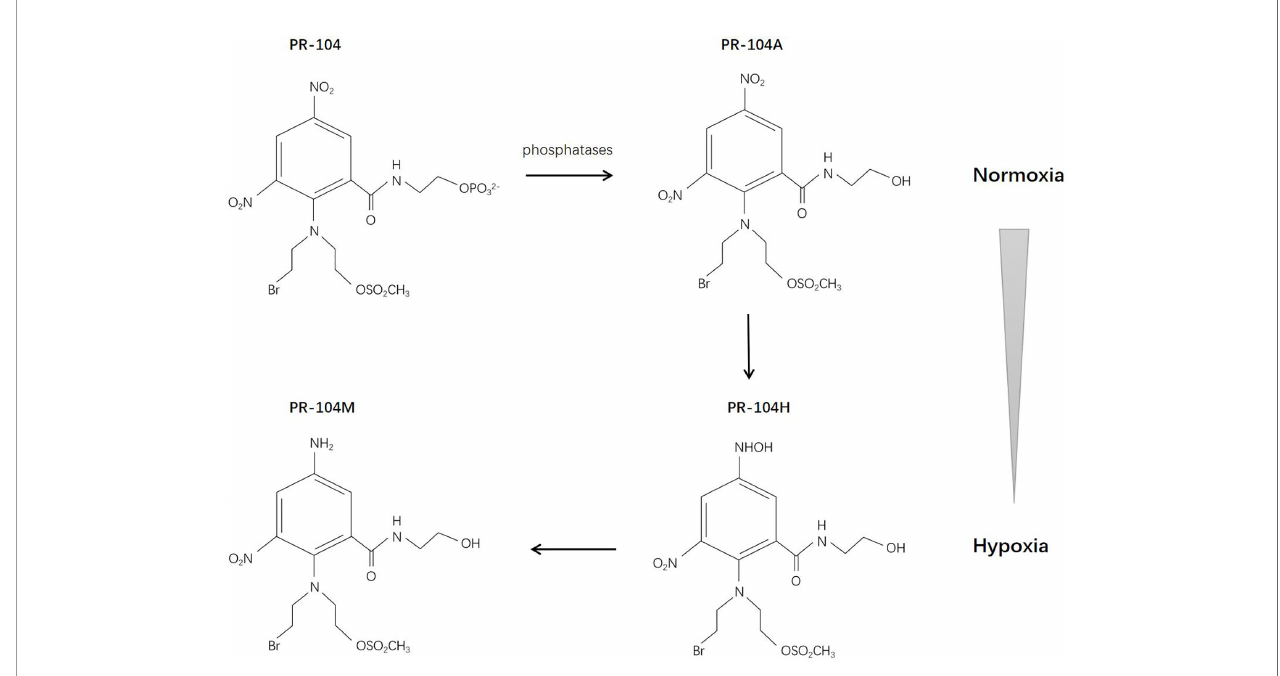
FIGURE 4 | Reductive reaction of